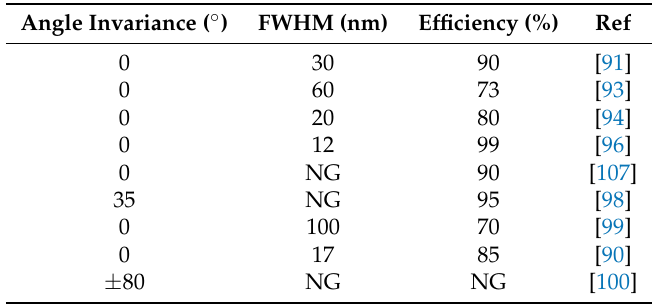
Table 2. 1D Diffraction-based color